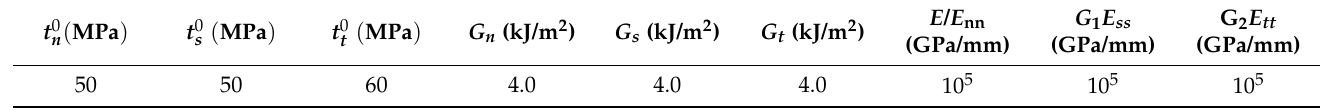
Table 6. Inter-laminar strength and fracture energies of cohesive interfaces of FM94 adhesive.